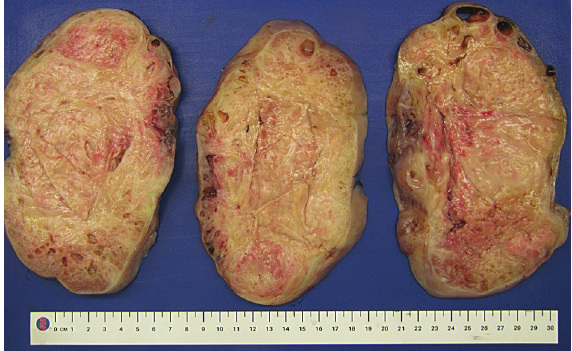
Figure 3: Macroscopic image of